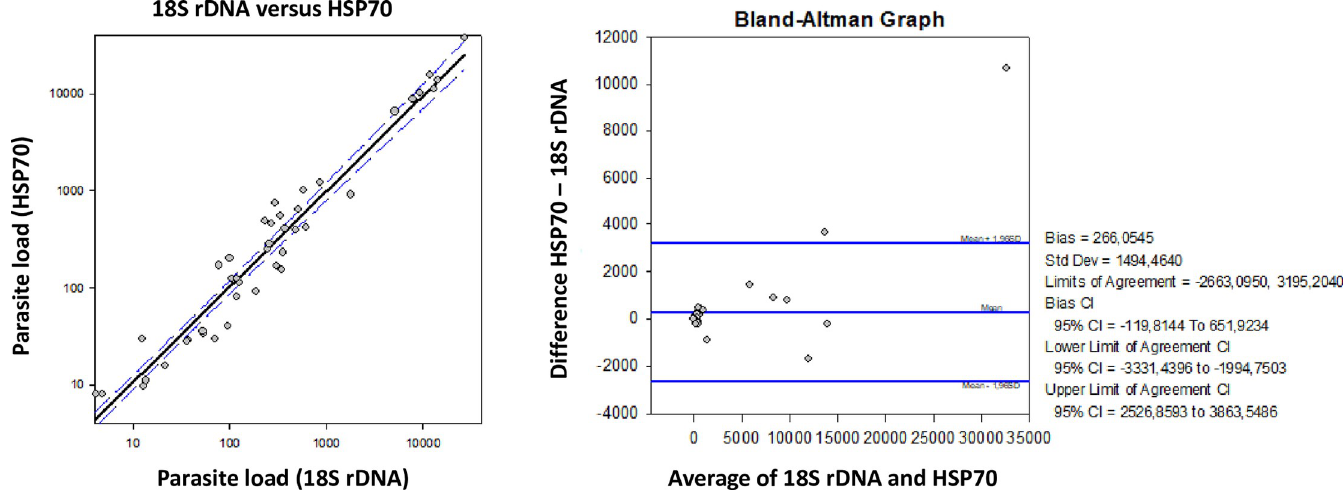
Fig 4. Agreement of parasite load quantification using 18S rDNA and HSP70. A. Parasite load plot (18S rDNA versus HSP70). B. Bland-Altman bias (difference) plot analysis for the agreement degree between parasite load quantification using 18S rDNA and HSP70 as targets.